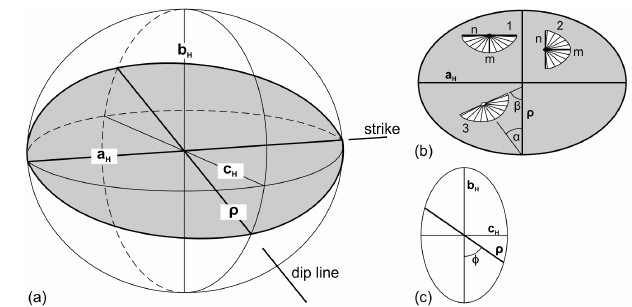
Figure 2. (a) Strain ellipsoid of Haughton (1856), intersected by a bedding plane (gray shaded) with strike parallel to a H and dip direc- tion parallel to the b H c H plane. (b) Plane view of the bedding with examples of deformed fossils of length n and breadth m . (c) Section of the strain ellipsoid across the b H c H